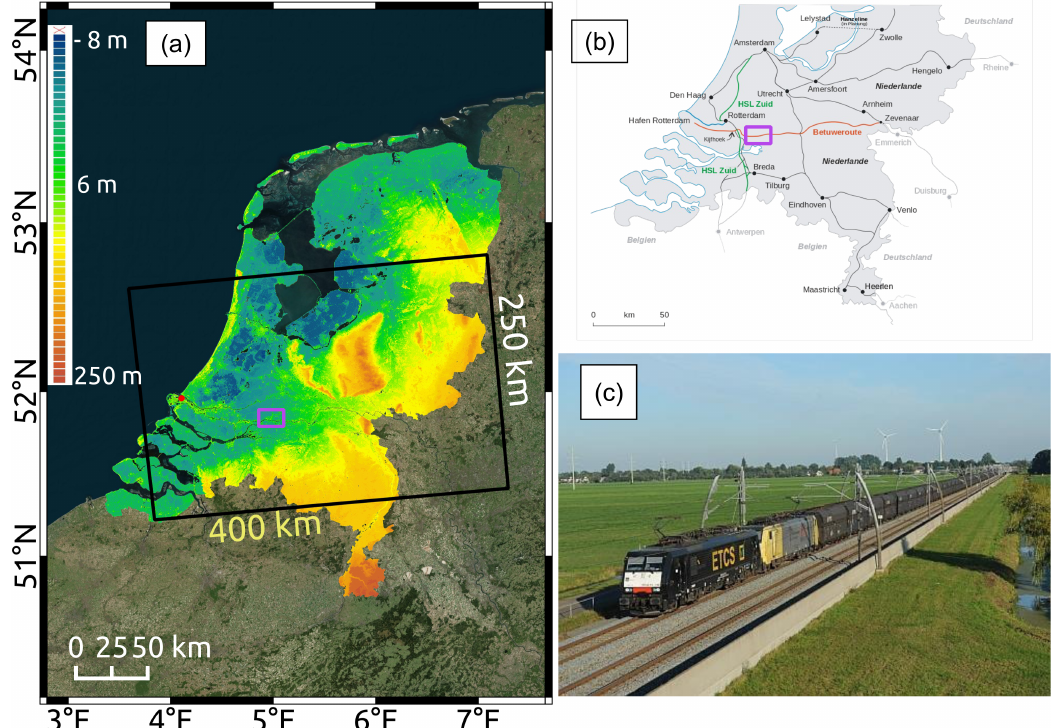
Figure 4. ( a ) Sentinel-1 satellite radar (SAR) data coverage (in black) over the Netherlands superimposed on an AHN3-derived Digital Surface Model (DSM) map. The extent of the test area is shown in purple. A GNSS station, as a reference point, is indicated in the red circle. ( b ) Dutch main railway network with the Betuwe route in red. ( c ) Train carrying heavy freight on the Betuwe dual